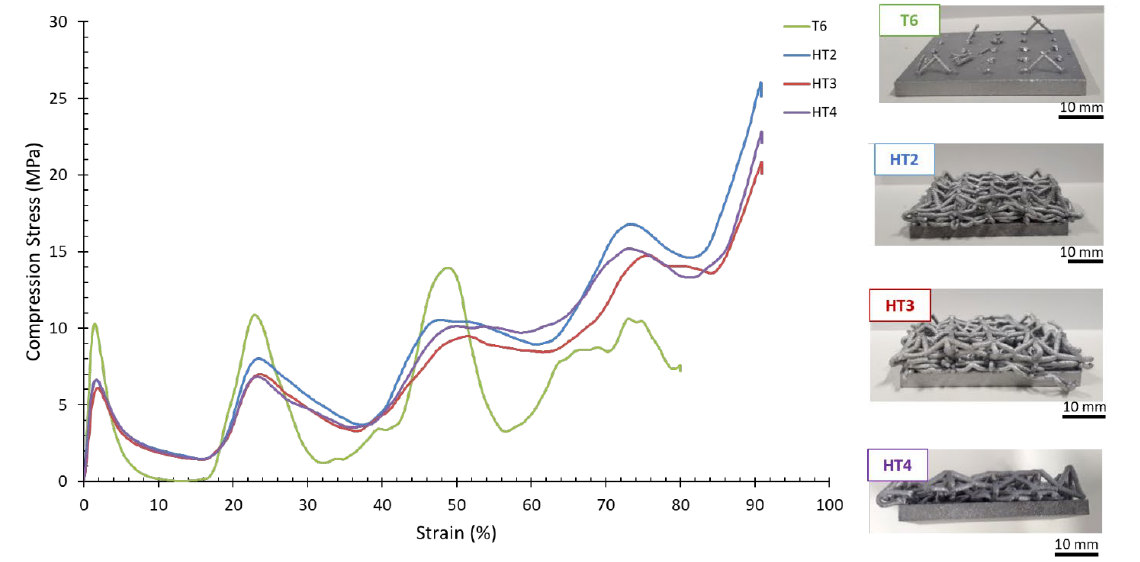
Figure 9. Compressive stress–strain diagramm for T6, HT2, HT3 and HT4. T6 showed the lowest strain, HT2, HT4 and HT4 showed the highest compressive strain.